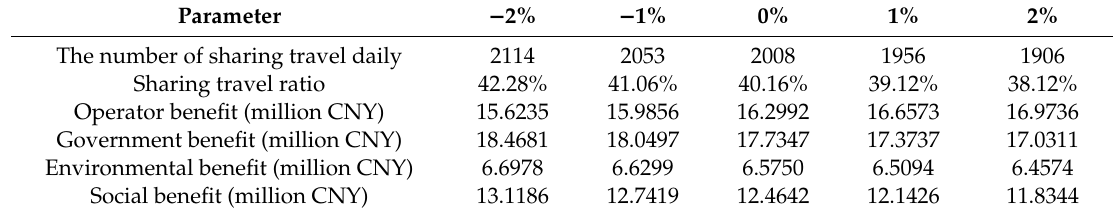
Table 3. Benefits of all participants after adjustment of prices.